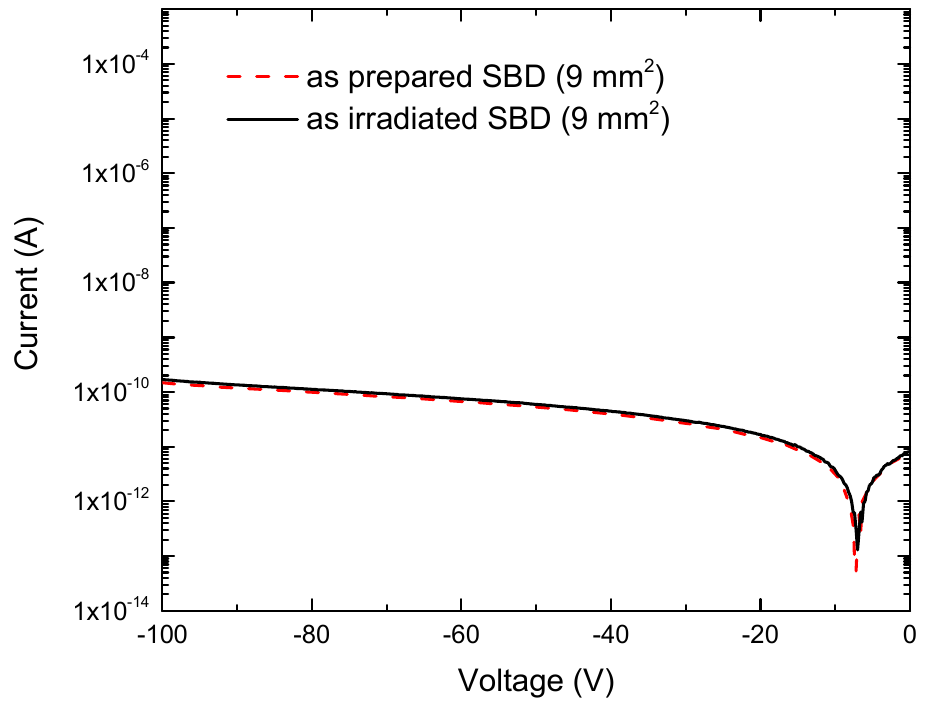
Figure 2. I-V measurement at RT of 4H-SiC SBD before and after the neutron radiation tests. Data adapted from Ref. [20].